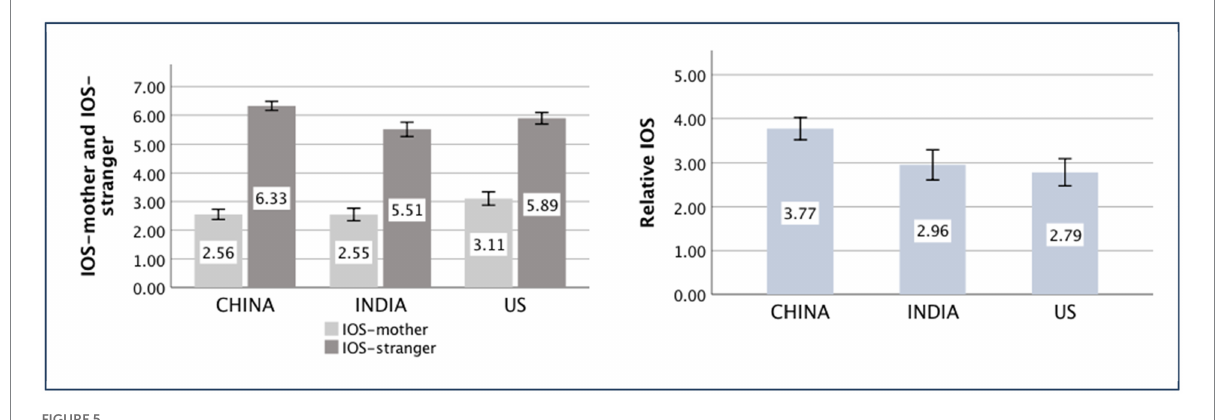
FIGURE 5 Inclusion of Other in the Self Scale of China, India, and the United States (US).